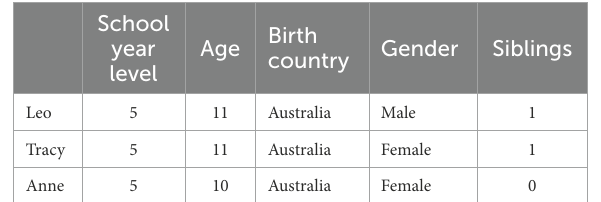
TABLE 1 Profile of the child